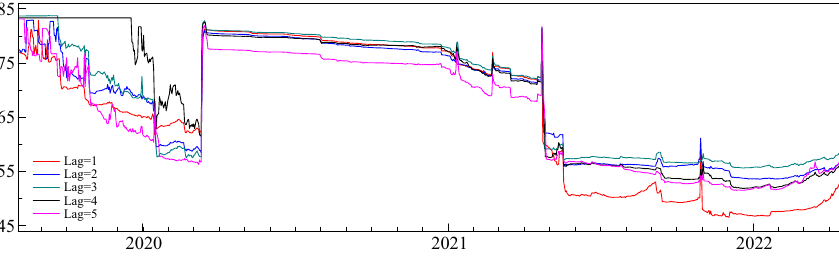
Fig. 36 Dynamic total RV connectedness with different VAR